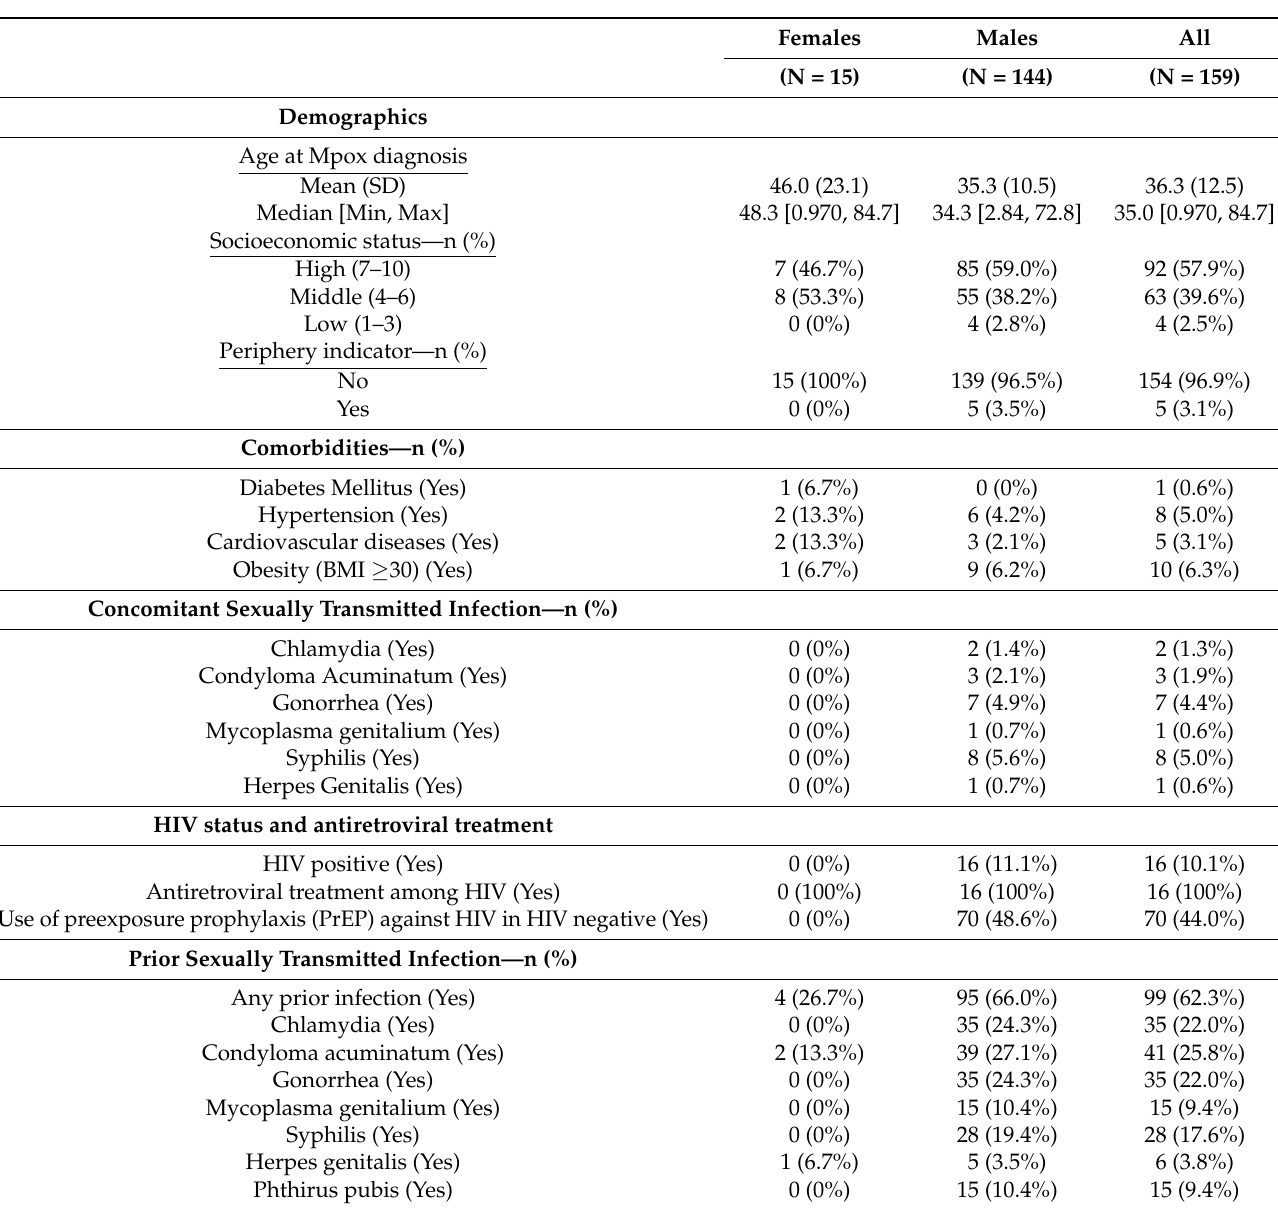
Table 3. Characteristics of males and females infected with Mpox between 4 May 2022 and 10 November